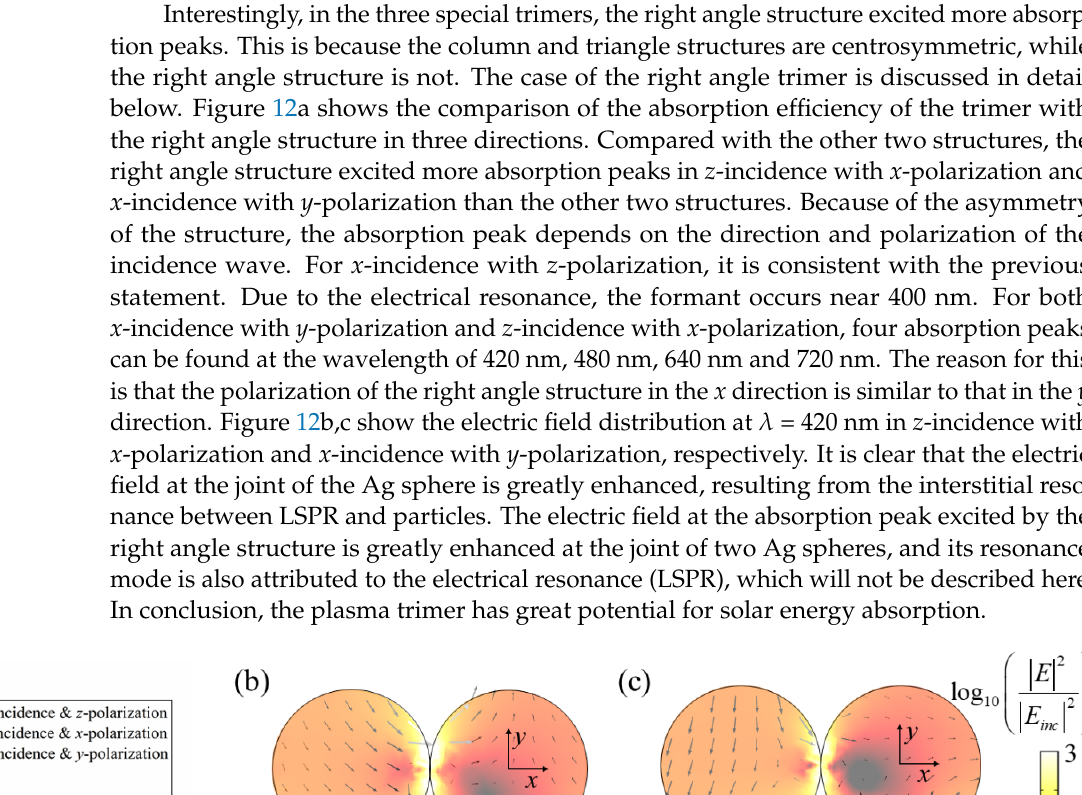
Figure 11. The ( a ) electric field and ( b ) resistive heat distributions of trimer at λ = 720 nm with z -incidence and x -polarization.